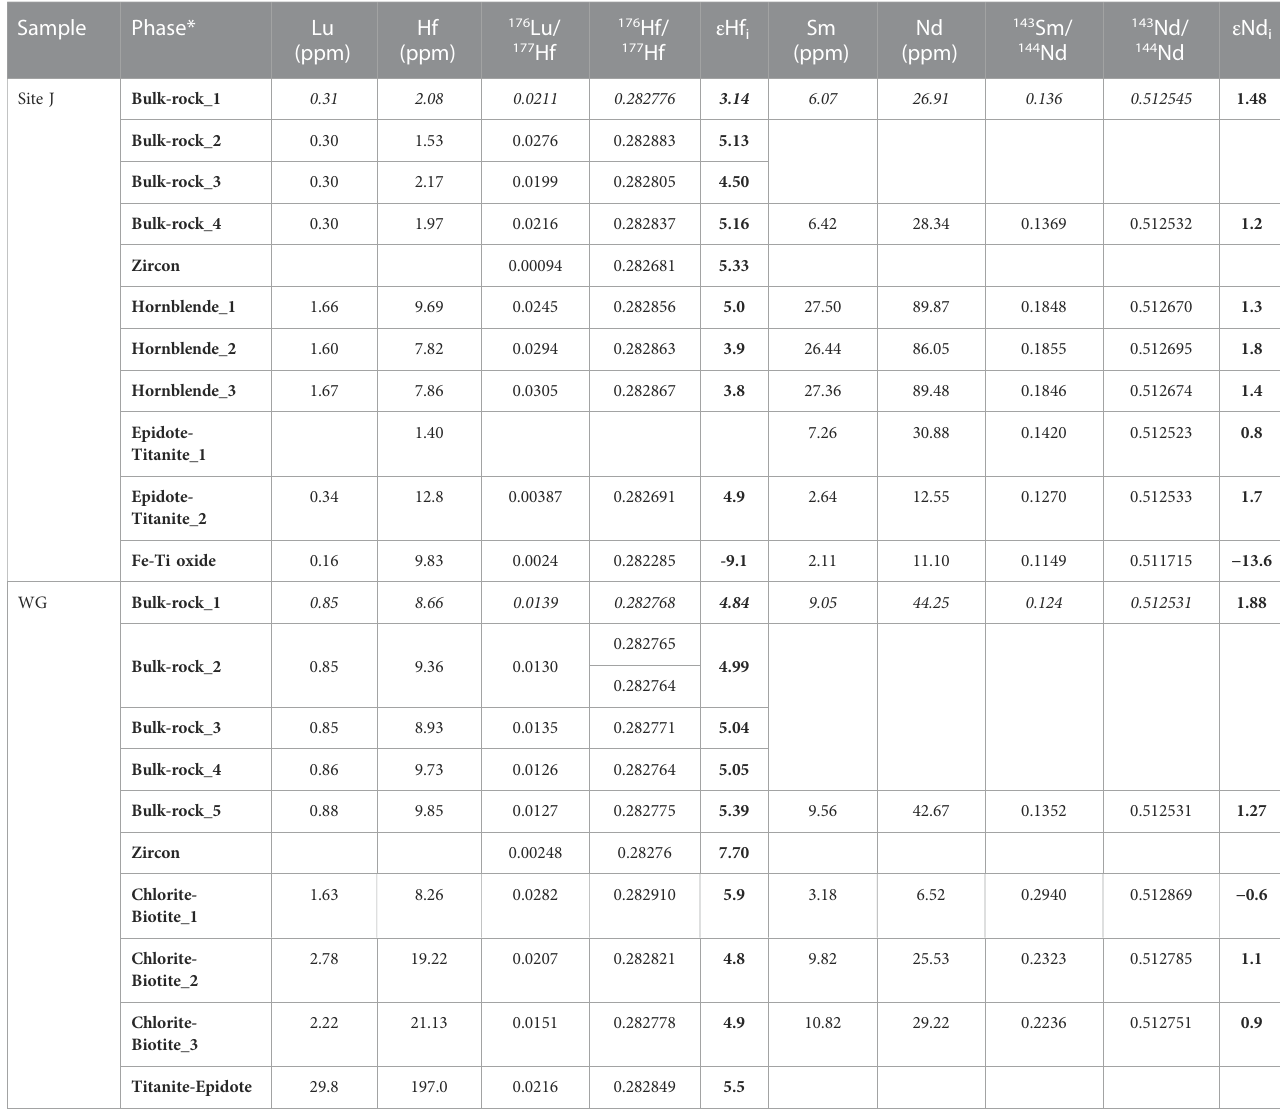
TABLE 3 Lu-Hf and Sm-Nd isotope data for mineral separates from Site J and the Woodlands Granite (WG). Bulk-rock and magmatic zircon data are included for comparison. Sample